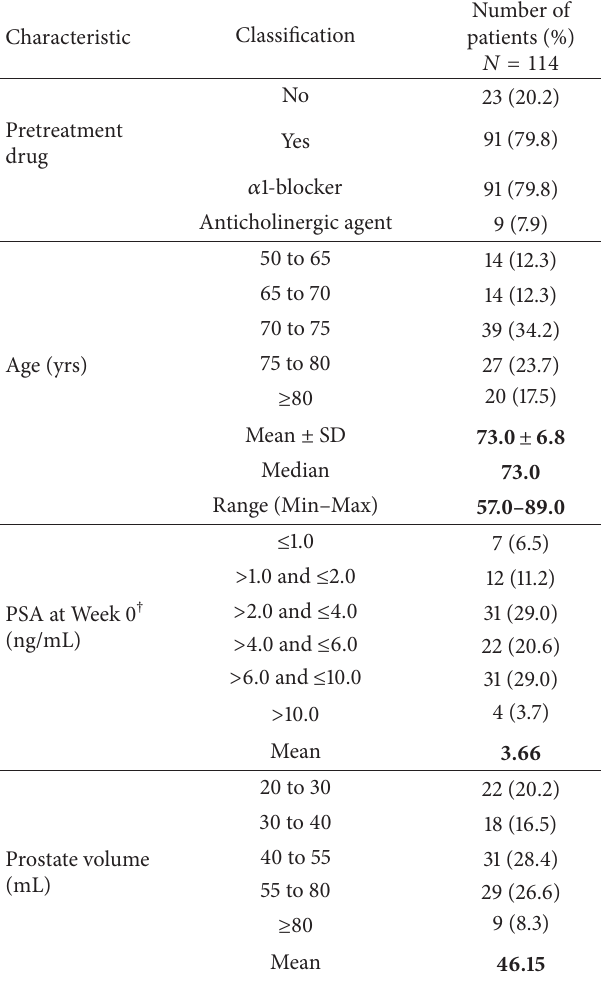
Table 1: Baseline characteristics of the patients.